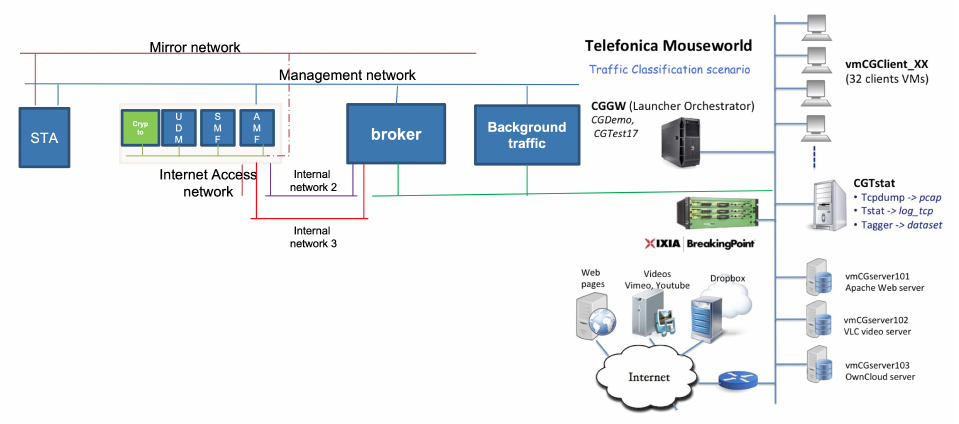
Figure 4. 5G core infrastructure and traffic injection tool (broker) integration in the Mouseworld